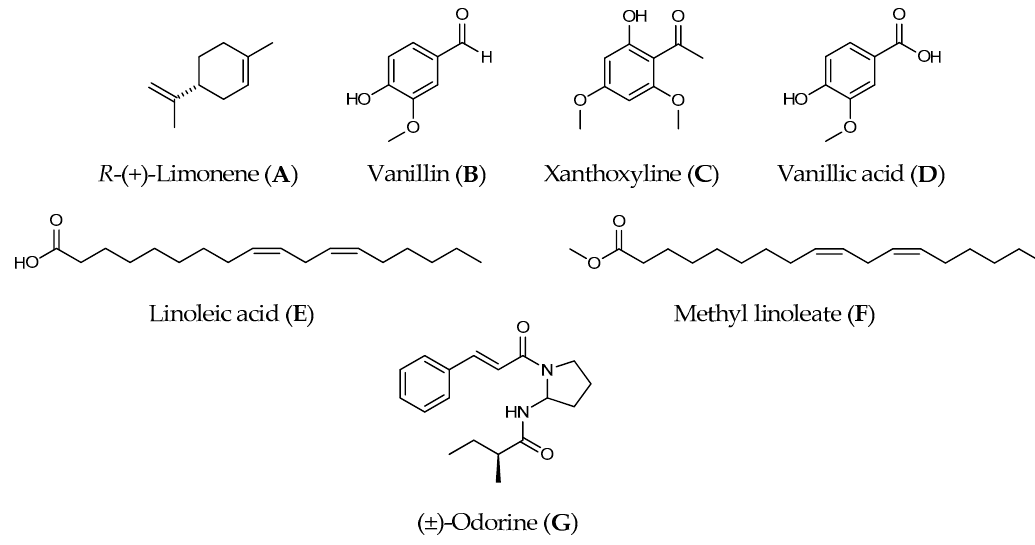
Figure 1. Allelochemicals used in this study.